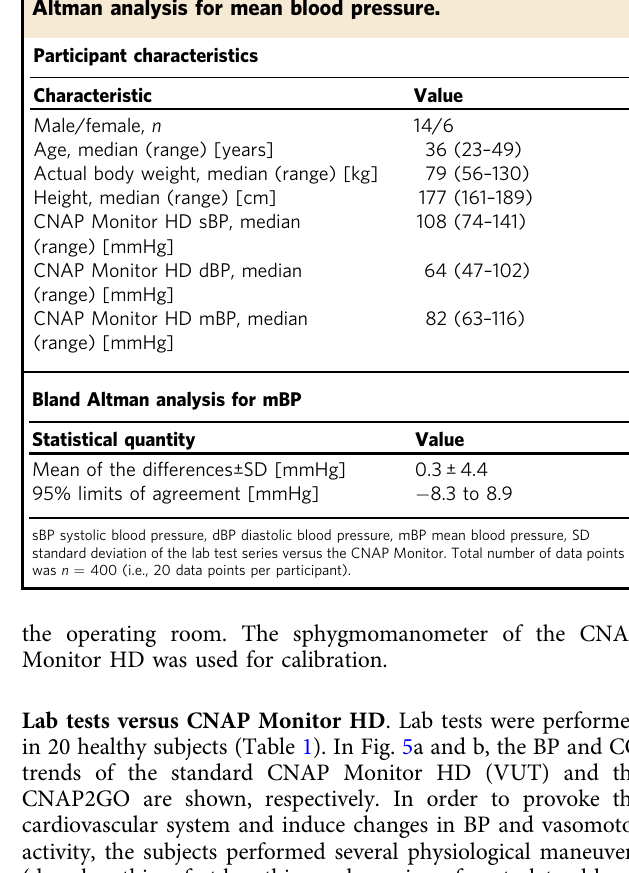
Table 1 Participant characteristics and results of Bland Altman analysis for mean blood